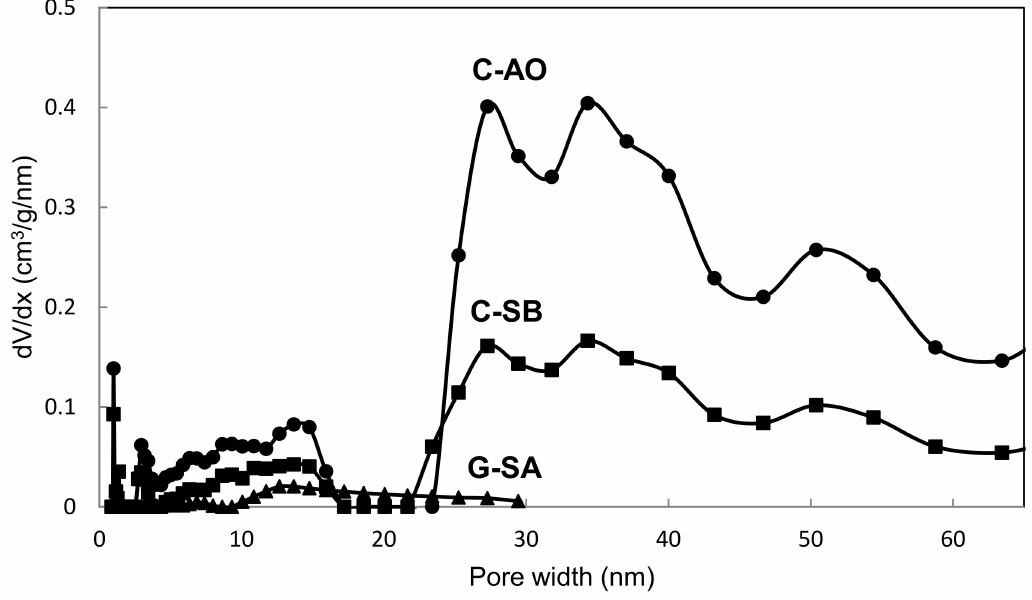
Figure 4. Pore size distribution of obtained cleaned carbon materials as well as graphite used in CPEs. Surface texture shown in SEM micrographs is given in Figures 5 and 6. The SEM images of both carbon materials are similar and represent a petal-like grapheme